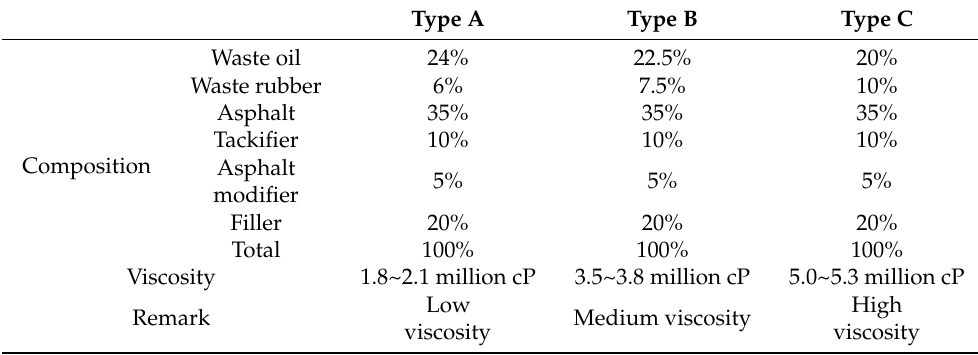
Table 1. Composition and viscosity of